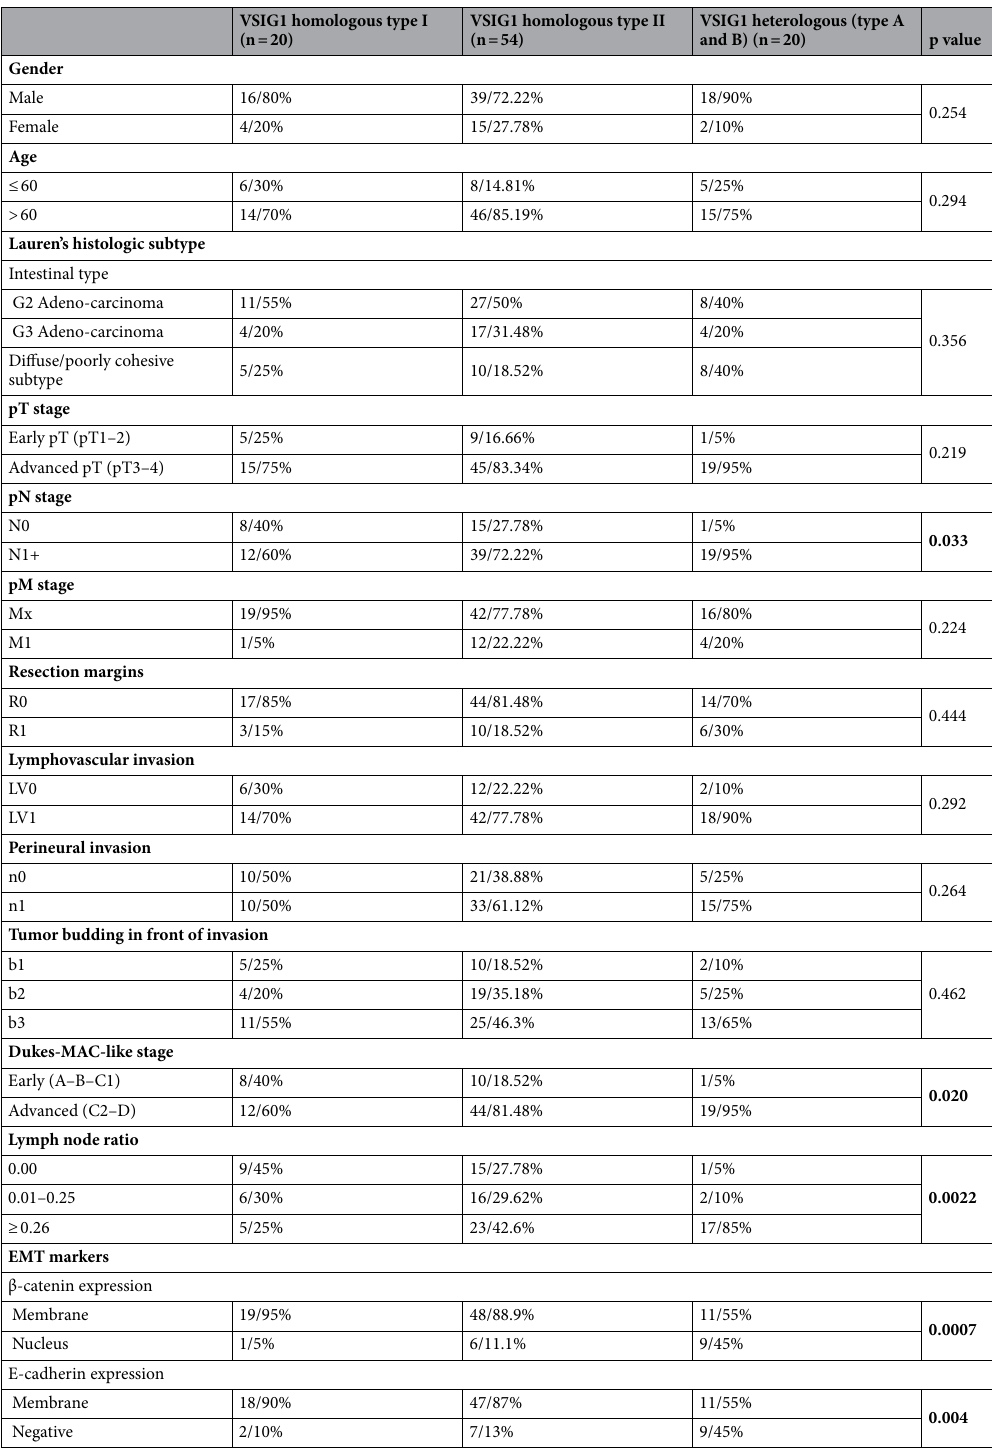
Table 2. VSIG1 pattern of expression is statistically significant correlated to regional lymph node status, lymph node ratio and Dukes-MAC-like stage, but not to tumor depth of invasion. At the same time, β-catenin and E-cadherin statuses are significantly different between the three VSIG1 patterns. Significant values are in